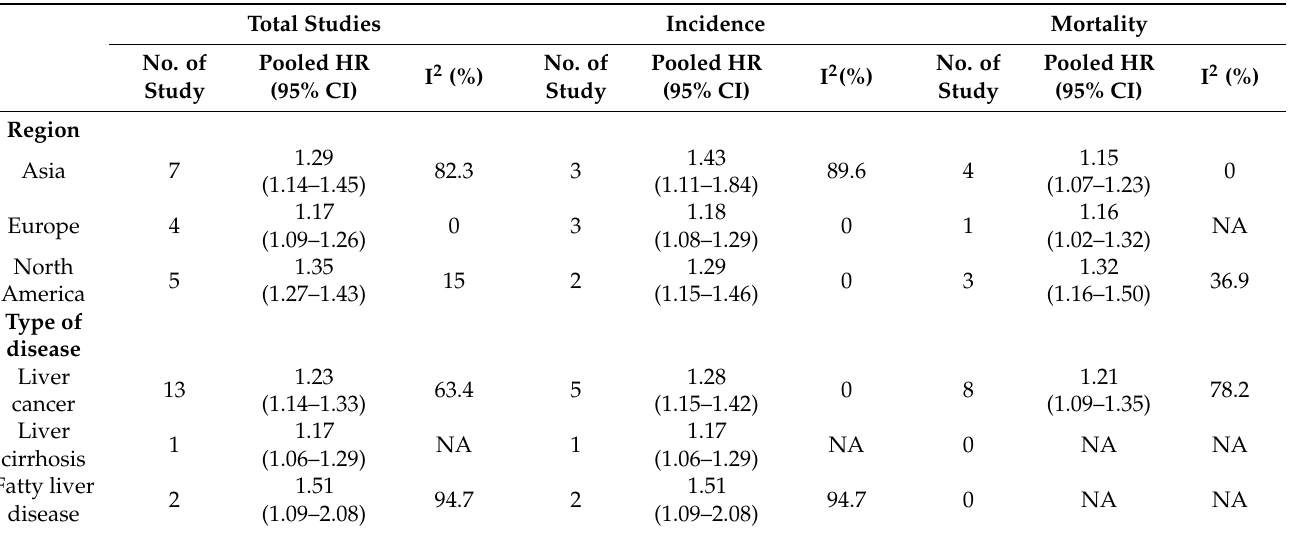
Table 2. Long-term exposure to fine particulate matter and risk of chronic liver diseases in the subgroup